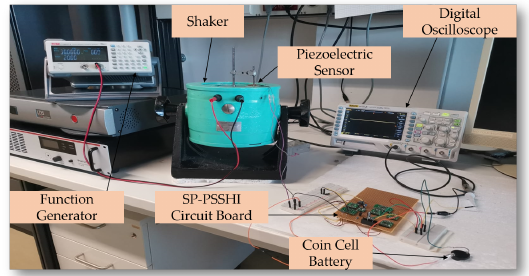
Figure 10. Experimental setup for piezoelectric harvester characterization and battery charging process.